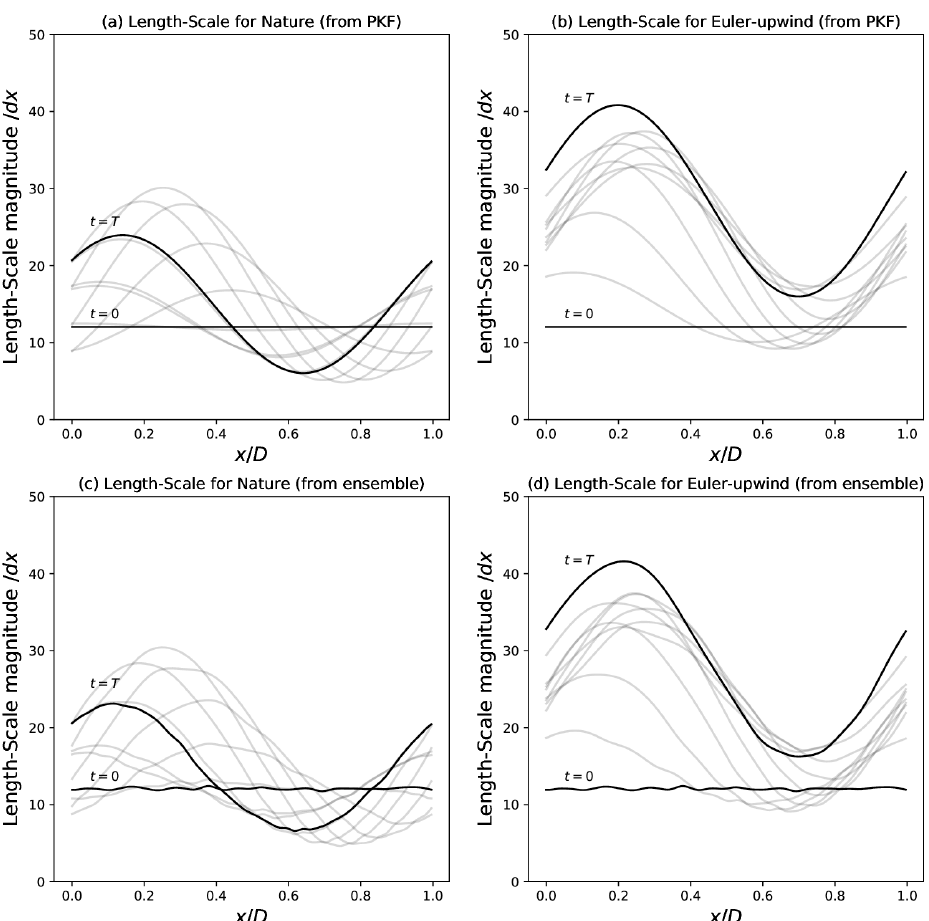
√ 2 ν and normalized